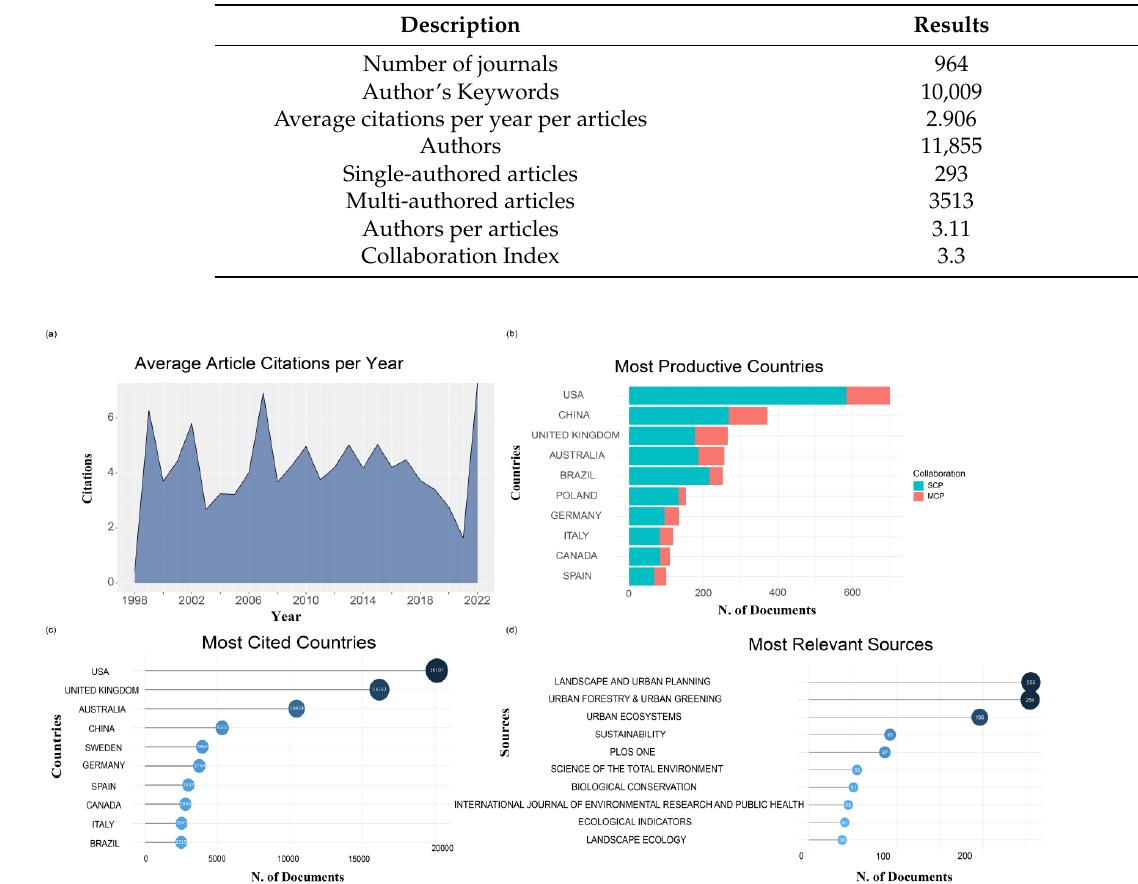
Table 1. Basic features of all the articles.